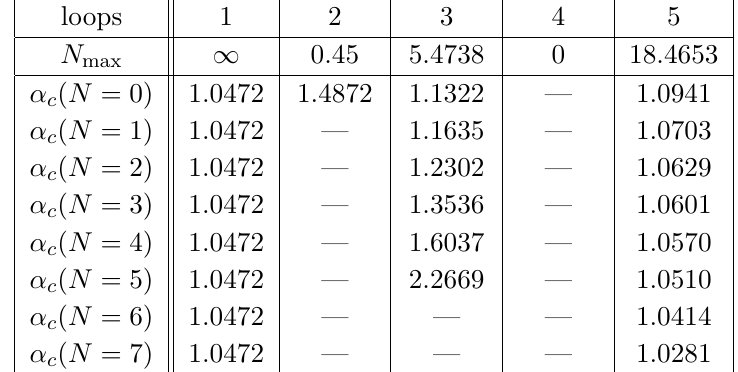
computed from (4.11) up to 5 loops (the 4